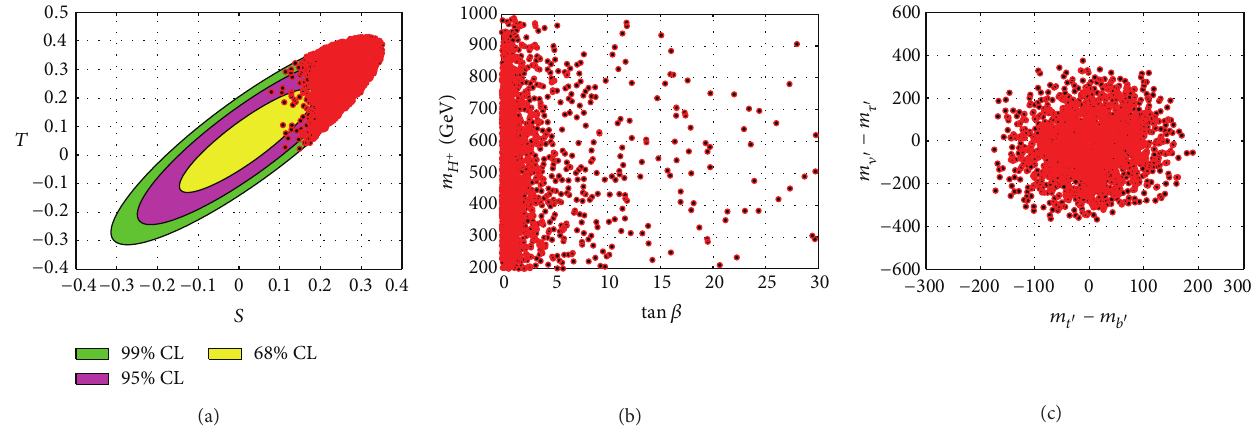
Figure 2: (a) The allowed points in parameter space projected onto the 68%, 95%, and 99% CL contours in the 𝑆 - 𝑇 plane. (b) 95% CL allowed range in the 𝑚 𝐻 + − tan 𝛽 plane. (c) Allowed region in the Δ𝑚 𝑞 󸀠 −Δ𝑚 ℓ 󸀠 plane within the 95 % CL contour in the 𝑆 - 𝑇 plane. All plots are for any 2HDM setup (such as the 2HDMII and the three types of the 4G2HDM; see text) and with 100000 data points setting the light Higgs mass to 𝑚 ℎ = 125 GeV and varying the rest of the parameters in the ranges tan 𝛽 ≤ 30 , 𝜃 34 ≤ 0.3 , 150 GeV ≤ 𝑚 𝐻 ≤ 1TeV, 150 GeV ≤ 𝑚 𝐴 ≤ 1TeV, ≤ 1TeV, 400 GeV ≤ 𝑚 , 𝑚 ≤ 600 GeV, 100 GeV ≤ 𝑚 , and 𝑚 ≤ 1.2 TeV and the CP-even neutral Higgs mixing angle 200 GeV ≤ 𝑚 𝐻 + 𝑡 󸀠 𝑏 󸀠 ] 󸀠 𝜏 󸀠 in the range 0 ≲ 𝛼 ≲ 2𝜋 .